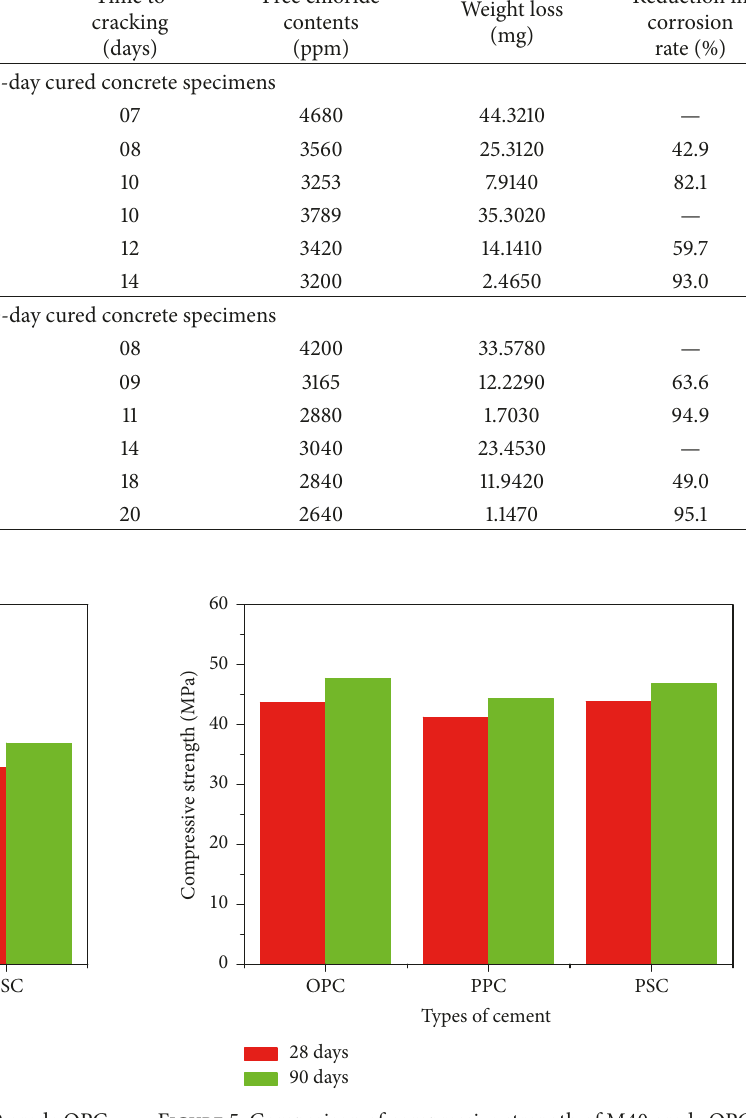
Figure 4: Comparison of compressive strength of M30 grade OPC, PPC, and PSC concrete types.